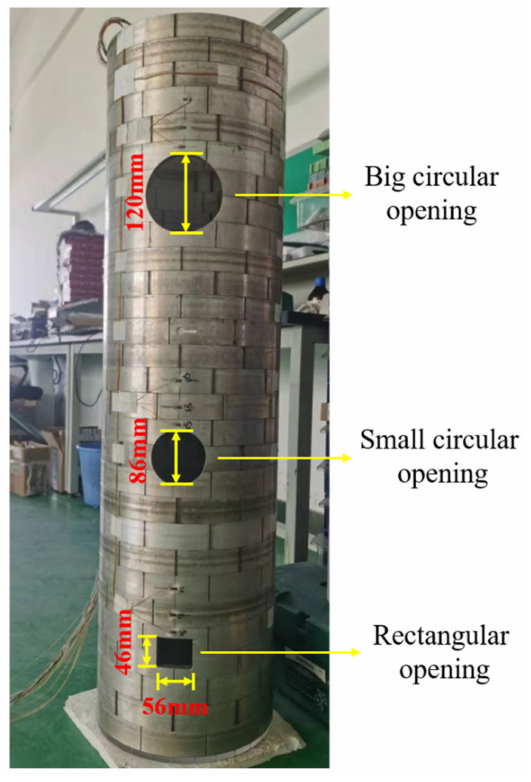
Figure 5. Three openings on the model